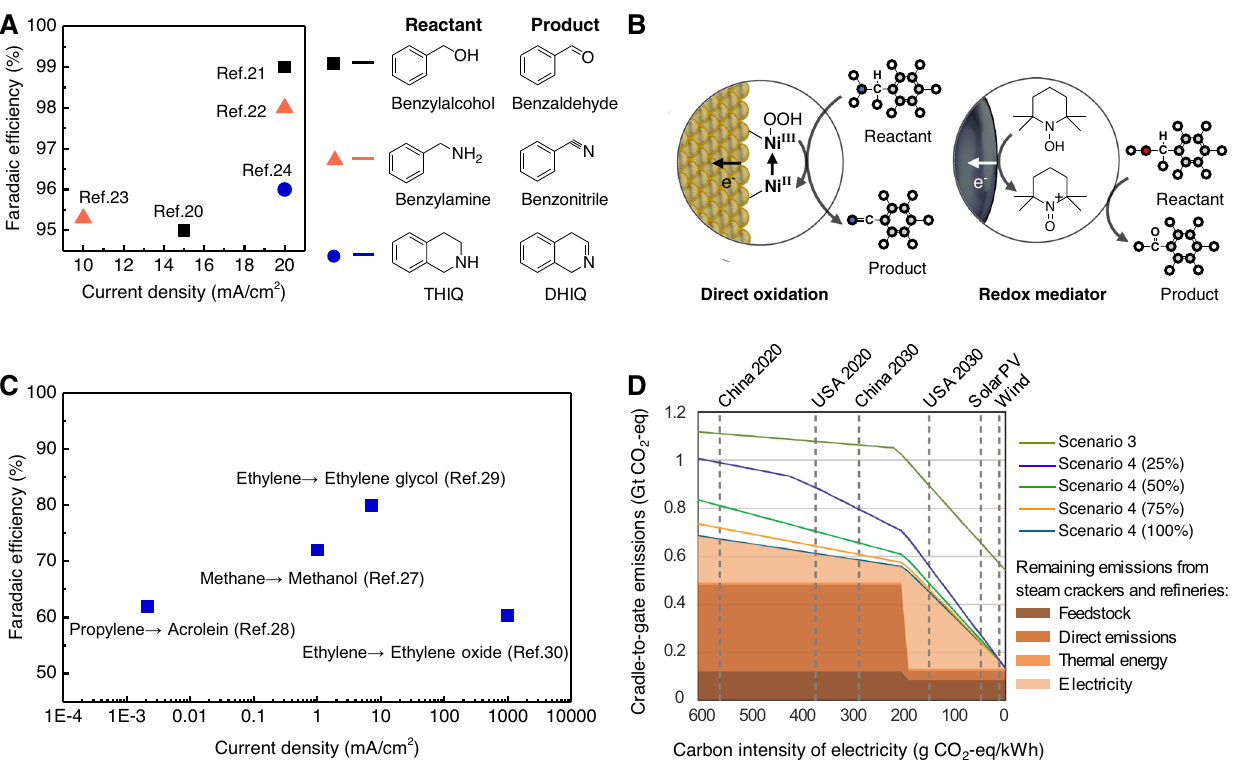
Fig. 3 | State-of-art anodic oxidation reactions. A Current densities and Faradaic ef fi ciencies of reported state-of-the-art anodic oxidation reactions. B Direct oxi- dation at the anode versus redox mediator. C Comparison of Faradaic ef fi ciency and current density of recent reported anodic hydrocarbon oxidations. D Sensitivity analysis of annual cradle-to-gate emissions with coupled electrolyzer